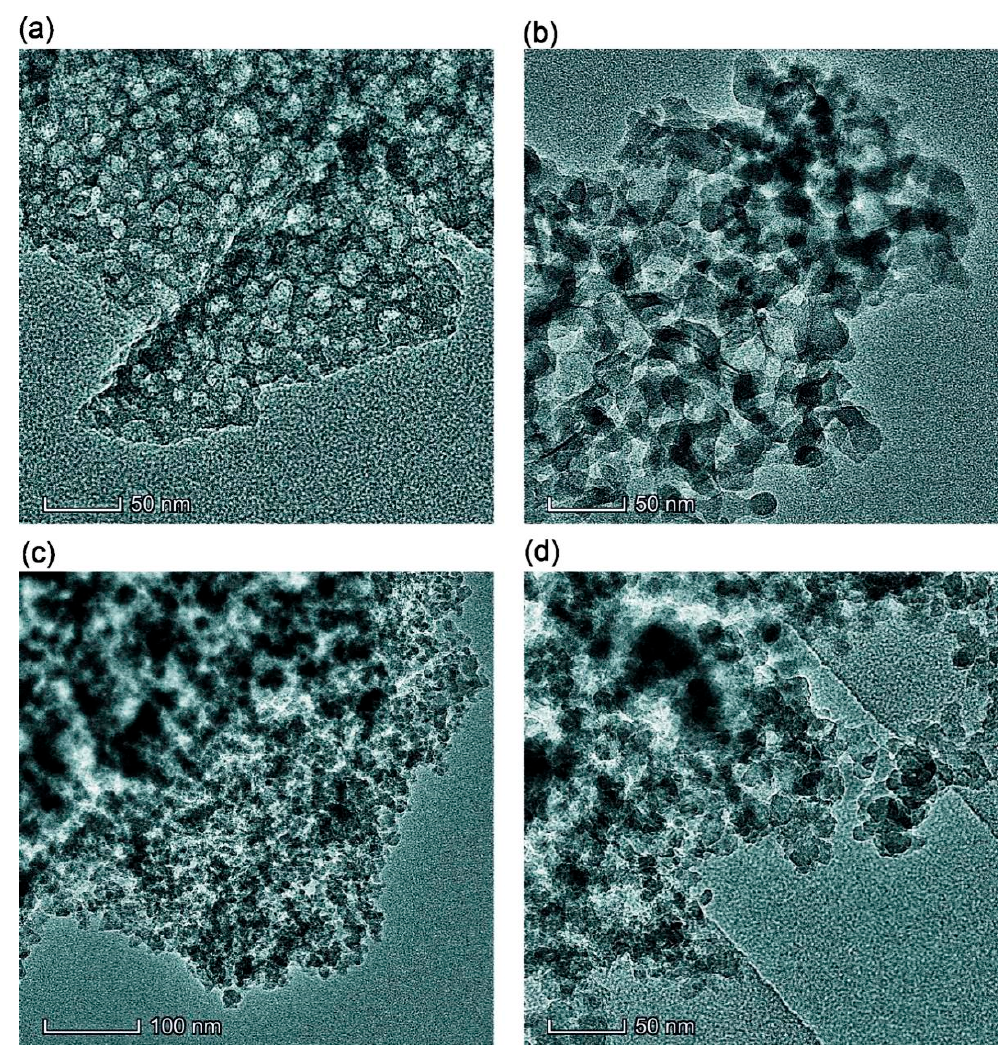
Figure 1. TEM images of samples ( a ) Bl, ( b ) Bh2s, ( c ) Adl, and ( d ) Pdl (scale bar 50 nm (a, b, d) and 100 nm (c)).